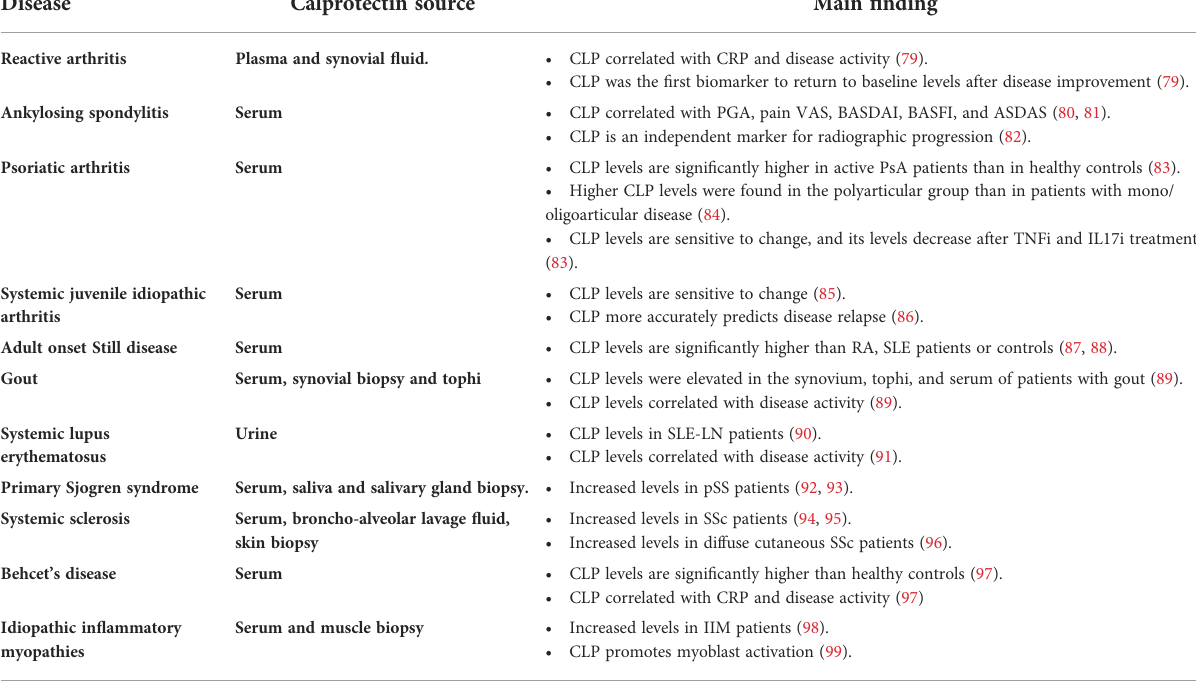
Disease Calprotectin source Main fi nding Reactive arthritis Plasma and synovial fl uid.